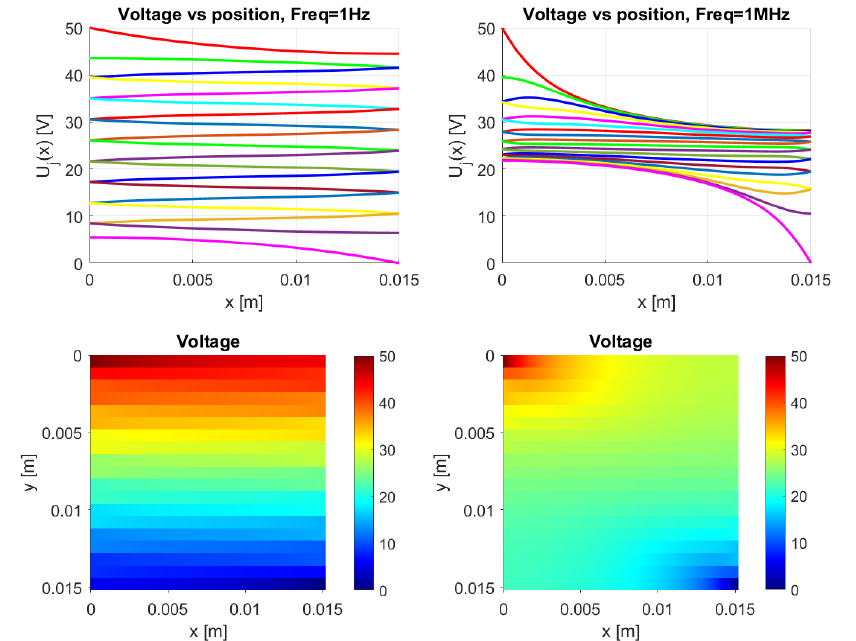
Figure 29. A demonstration of the ac model, showing the voltage plots. Traxel conduction occurs at 1Hz and bulk conduction occurs at 1MHz, while using the parameters C 0 = 2.8 × 10 − 5 Fm − 2 , (cid:101) r = 5, ρ = 2.8 Ω m, and σ = 0.2 Ω m 2 . According to this model, the frequency-dependence can significantly influence the electrical conduction through 3D-prints.